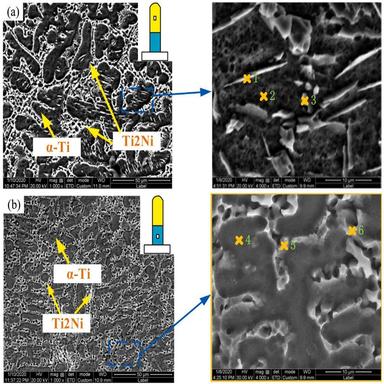
SEM images and EDS test locations from different layers.